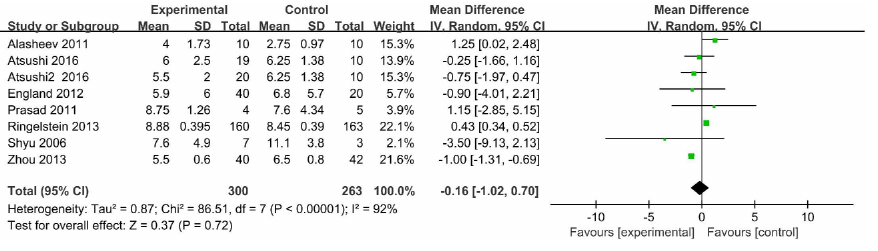
Fig 4. National Institutes of Health Stroke Scale scores.